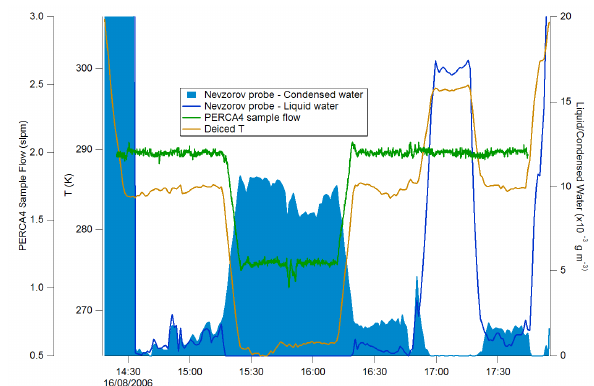
Fig. 6. Time series of PERCA 4 sample flow, with temperature and water content during the intercomparison flight.